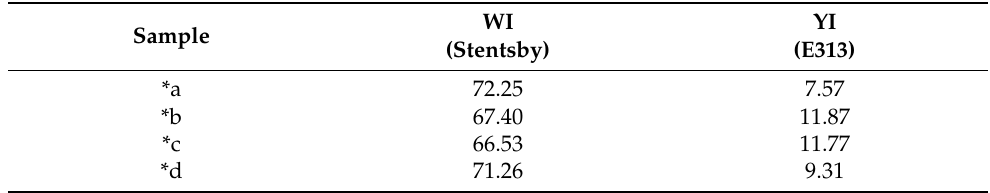
Table 3. Whiteness index (WI) and yellowness index (YI) results.